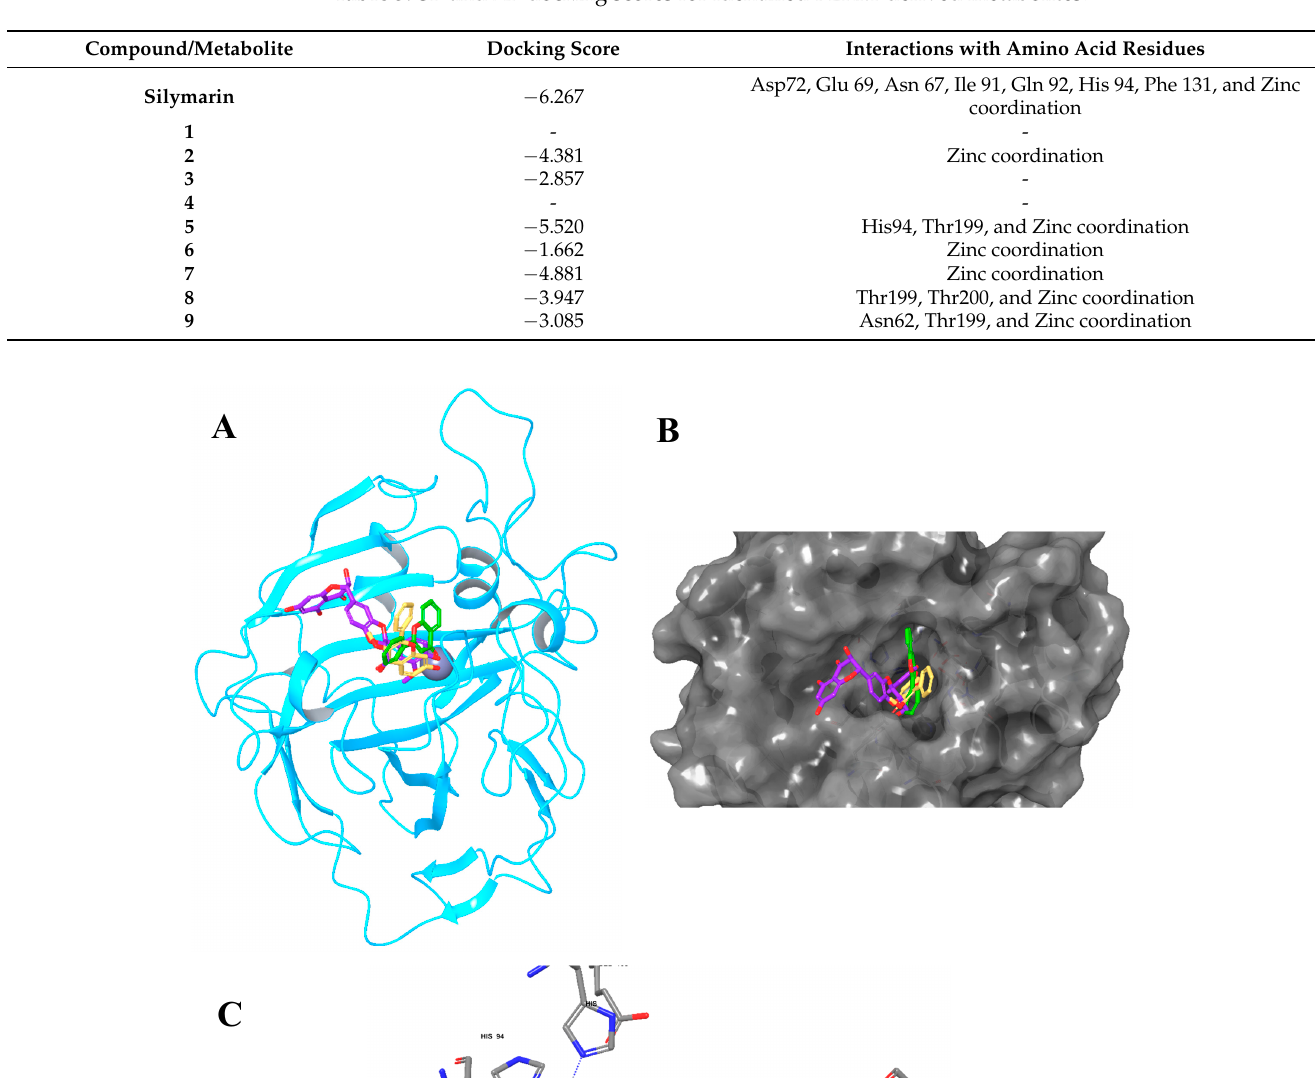
Table 3. SP and XP docking scores for identified BERM-derived metabolites.